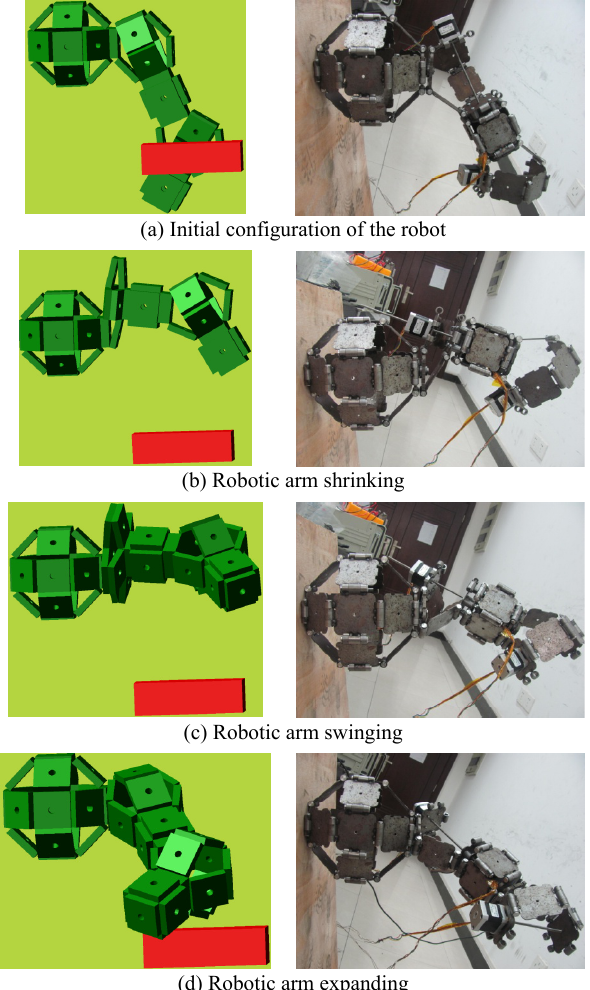
Figure 11. Obstacle avoidance motion test of the robotic